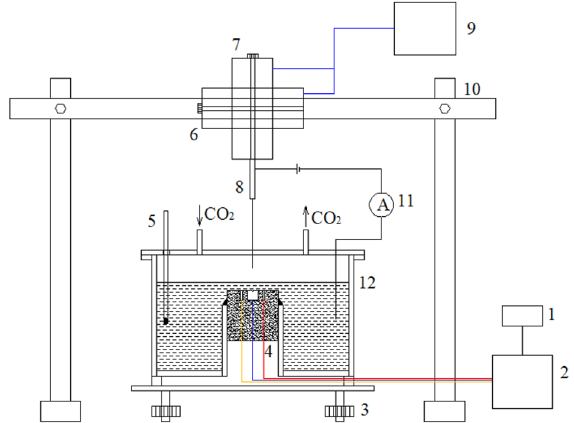
Figure 1. Static Corrosion test platform under liquid film: (1) data acquisition computer, (2) electrochemical workstation, (3) adjustment nut, (4) testing electrode, (5) thermometer, (6) horizontal displacement mechanism, (7) vertical displacement mechanism, (8) conductivity probe, (9) displacement control computer, (10) gantry frame, (11) micro ammeter, (12) solution container.